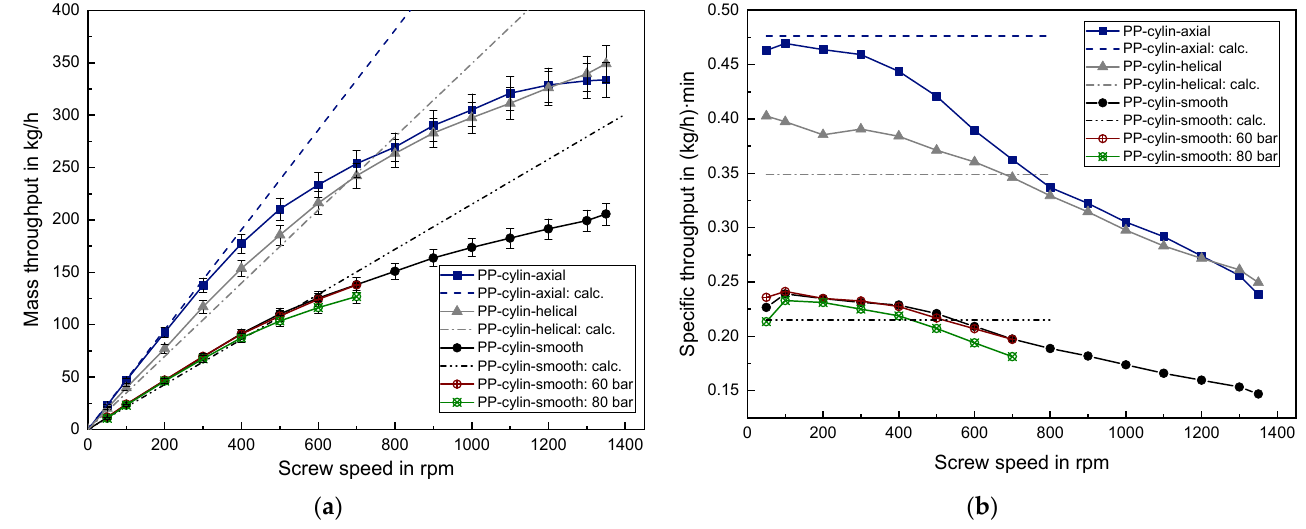
Figure 9. ( a ) Absolute mass throughput and ( b ) specific mass throughput for cylindrical PP.